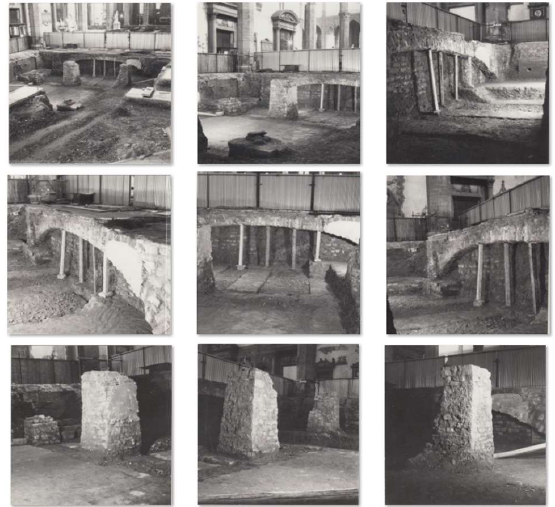
Figure 2 . Selection of the historical b/w photographs of the excavations in the Basilica of Santa Croce in Florence that have been used for photogrammetric processing.